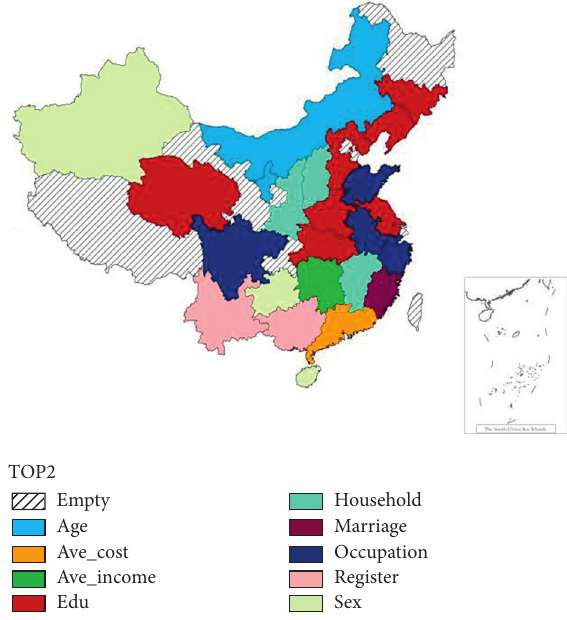
Figure 6: The second factor in each province.